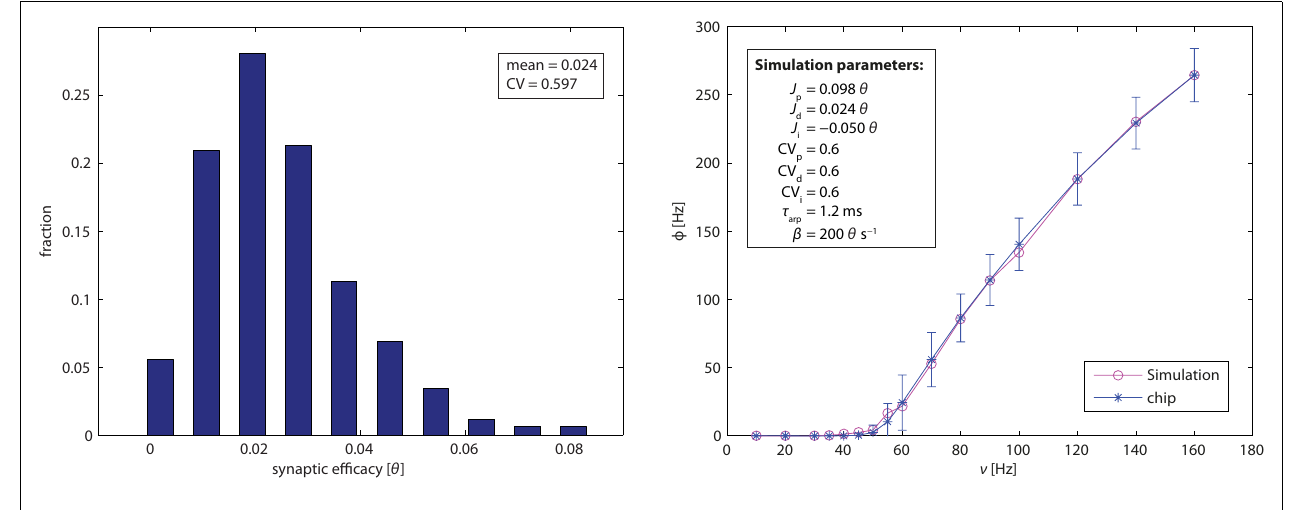
primarily to device mismatch in the leakage current β and in the absolute refractory period τ arp . Mean of simulation results (red symbols) for an ideal neuron and 120 synapses drawn from a Gaussian distribution of efficacies (see inset and text for details). CV stands for the coefficient of variation of the efficacy